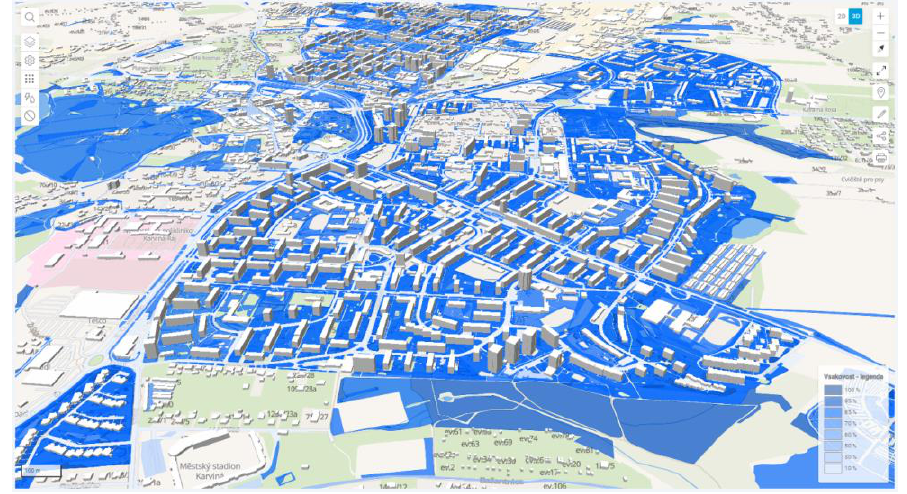
Figure 3. Application process of the R-WIM tool (source: authors).